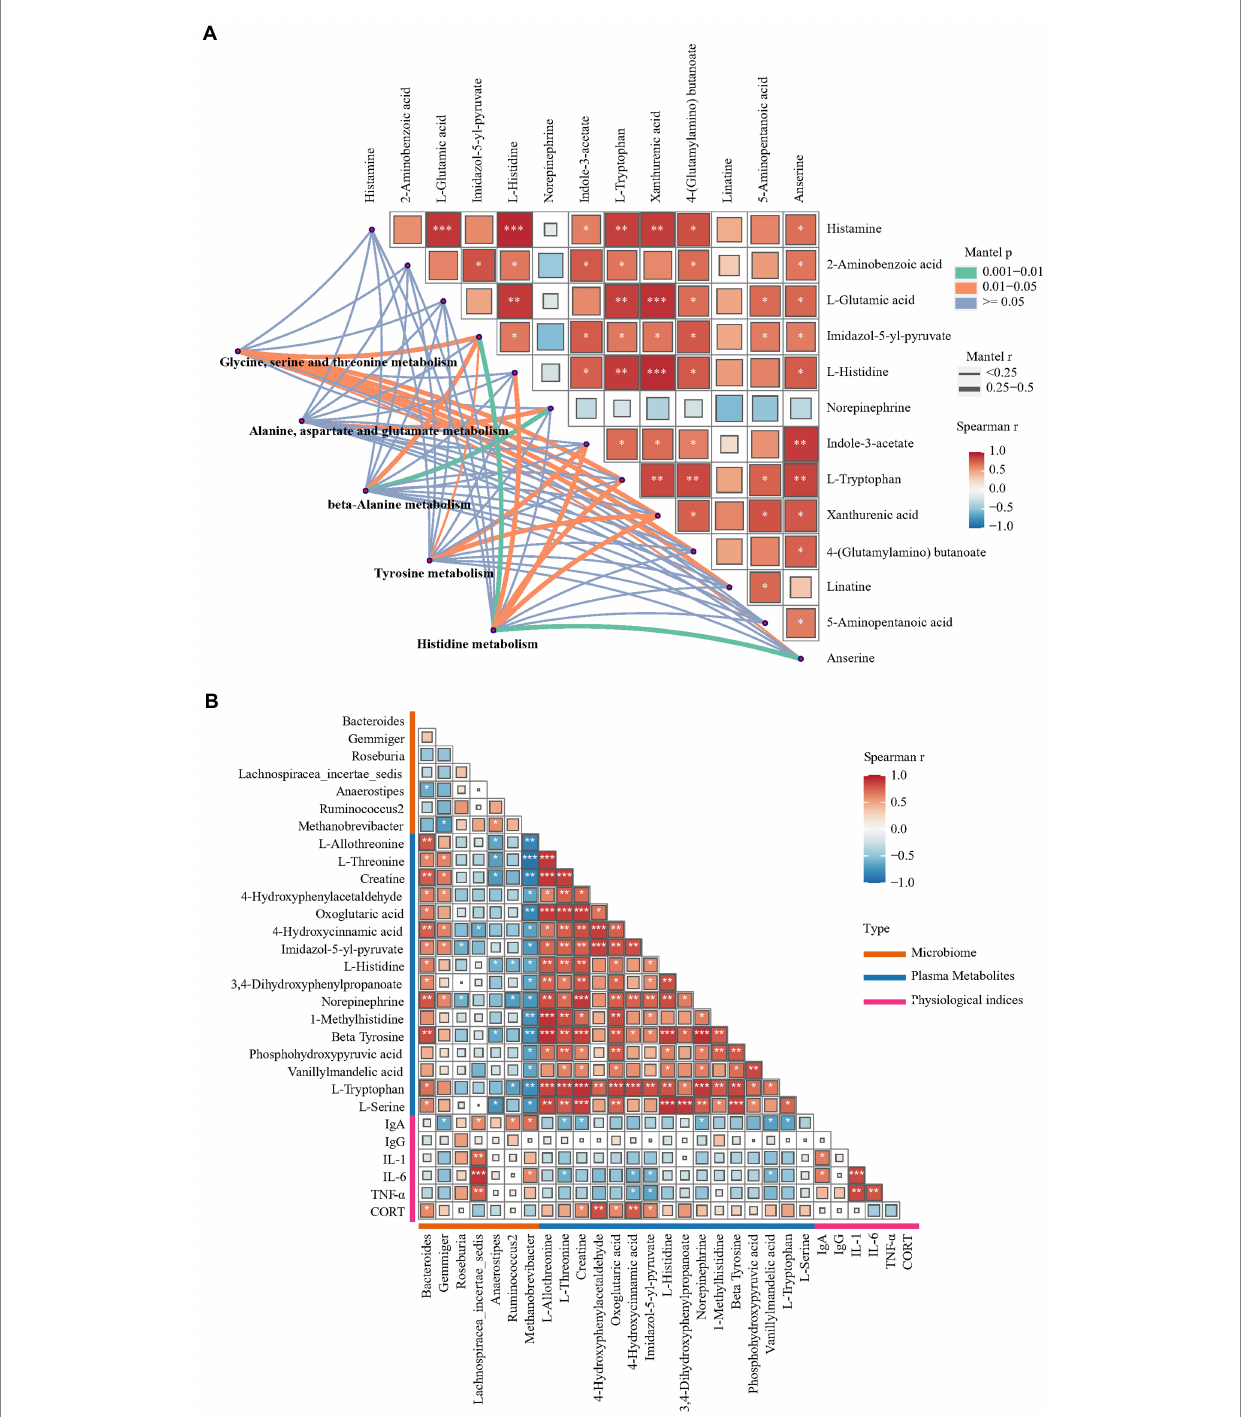
FIGURE 7 Correlation analysis between gut microorganisms, metabolites and plasma physiological indices. (A) Pairwise comparisons of hippocampus metabolites, with a color gradient denoting the Spearman’s correlation coefficients. Plasma KEGG pathways enriched with differential metabolites was correlated with each hippocampus metabolites by partial Mantel tests. Curve width represents the significant correlation coefficients ( p < 0.05) of the partial Mantel tests. (B) Spearman’s correlation analysis between differential microorganism, plasma differential metabolites and plasma physiological